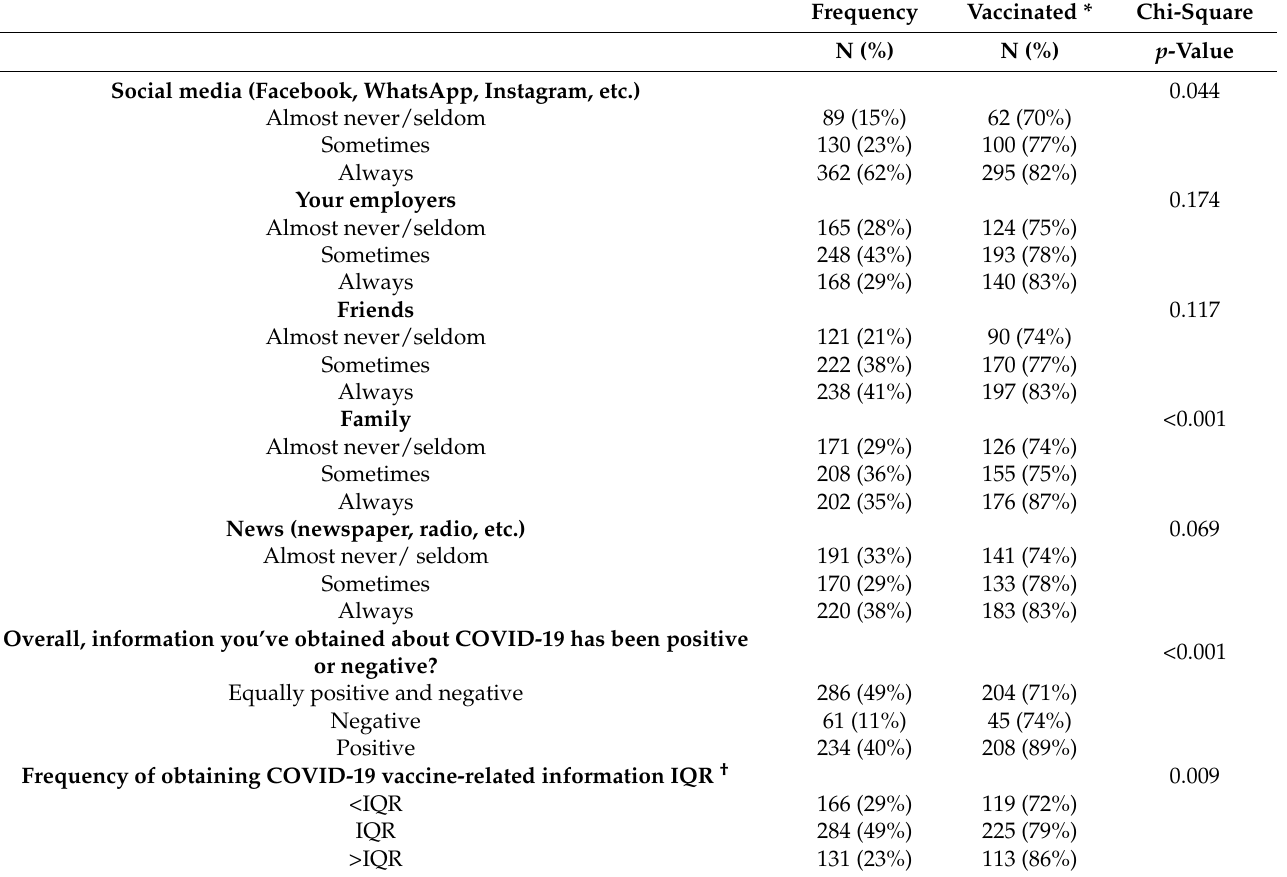
Table 3. Past month source and frequency for obtaining information about COVID-19 vaccines ( n = 581).